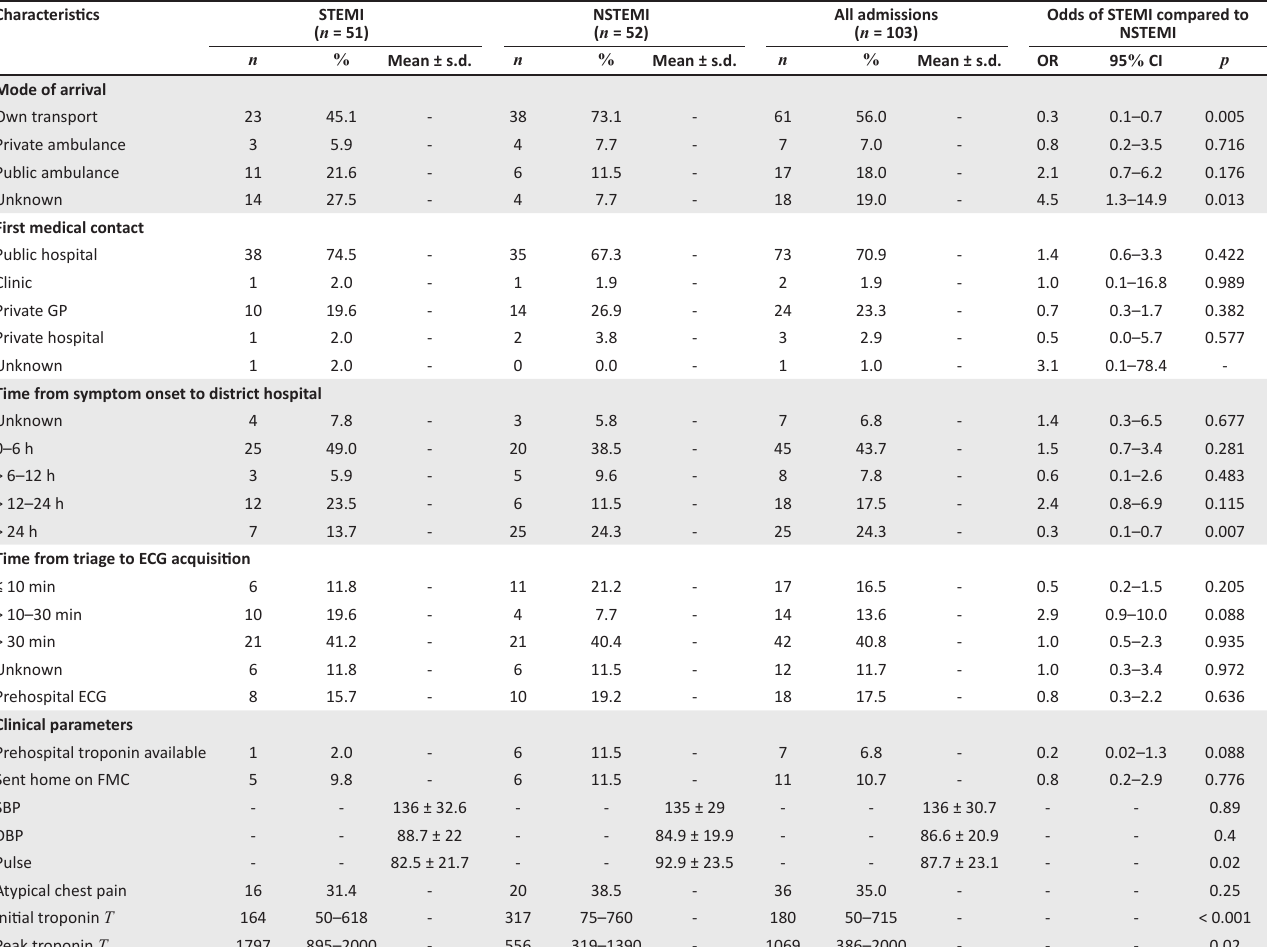
TABLE 2: Timing, clinical parameters, and immediate management of patients with acute myocardial infarction. Characteristics